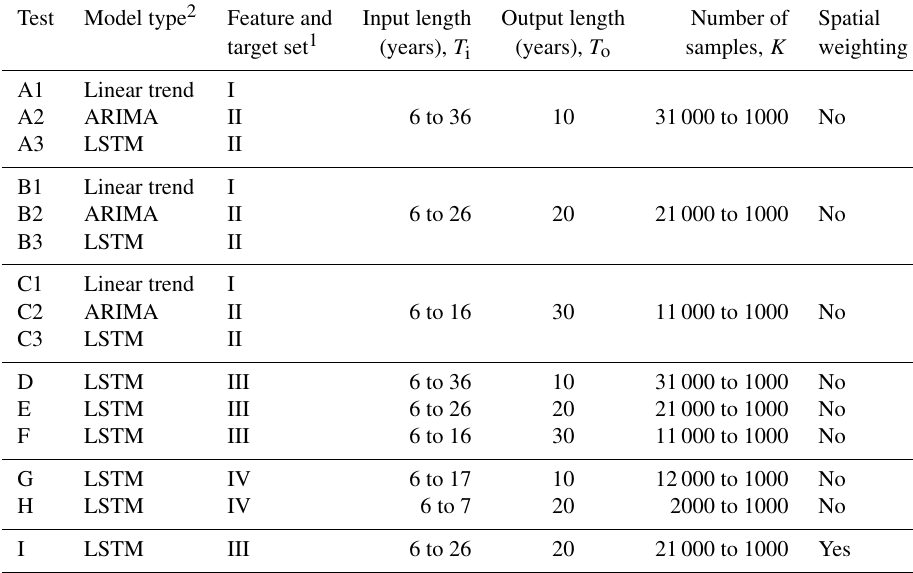
Table 2. Model tests.